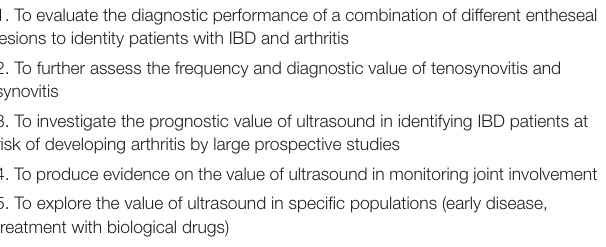
TABLE 4 | Research Agenda of US in IBD without a diagnosis of